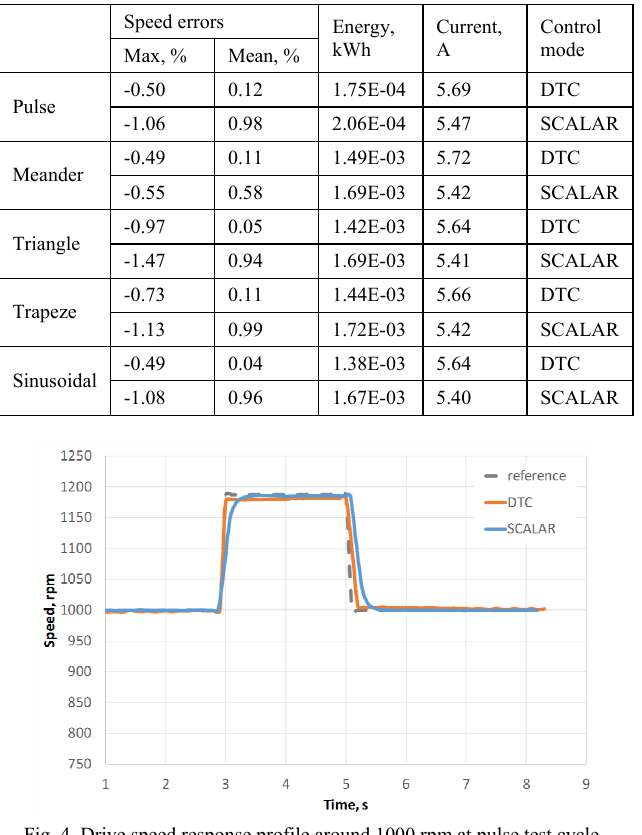
Fig. 8. Drive speed response profile around 1000 rpm at sinusoidal test